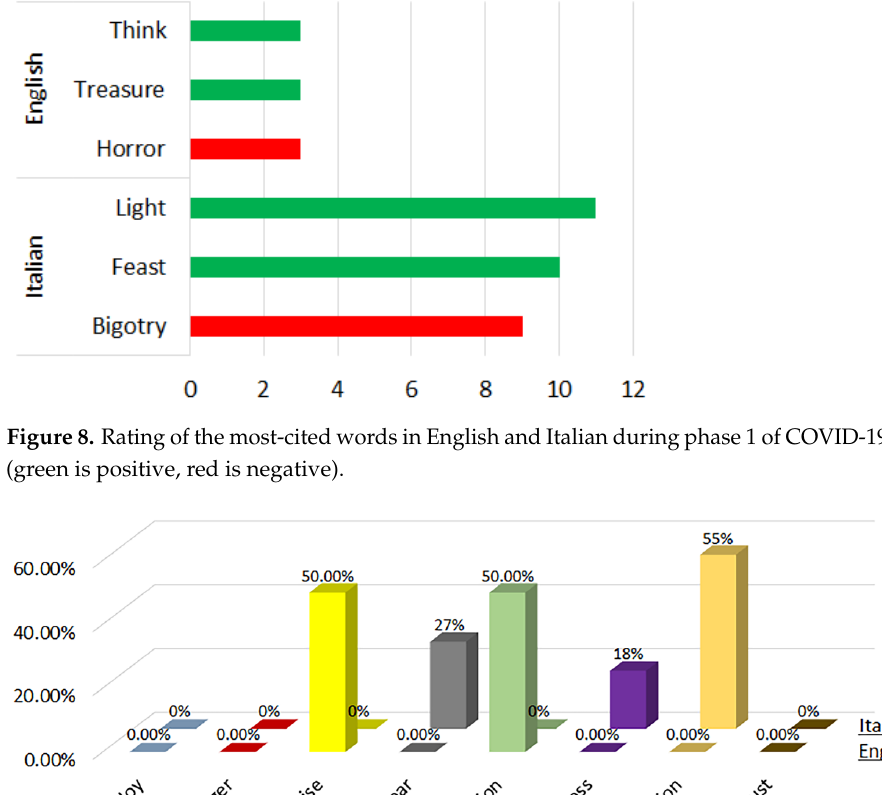
Figure 10. Rating of the most-cited words in English and Italian during phase 2 of COVID-19 pan- demic (green is positive, red is negative). Figure 11. Percentage distribution of every primary emotion for English and Italian words during phase 3 of COVID-19 pandemic.